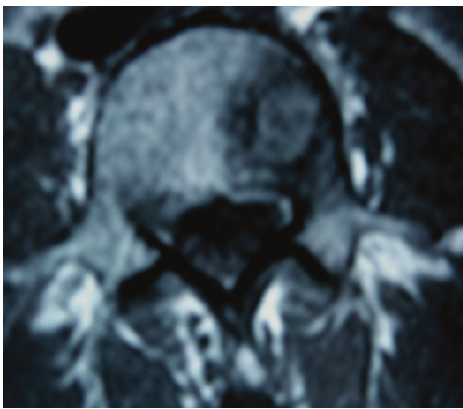
Figure 4 - Magnetic resonance showing an axial section through the fourth lumbar vertebra in a T1 sequence, demonstrating alteration in the vertebral body at the base of the left pedicle.